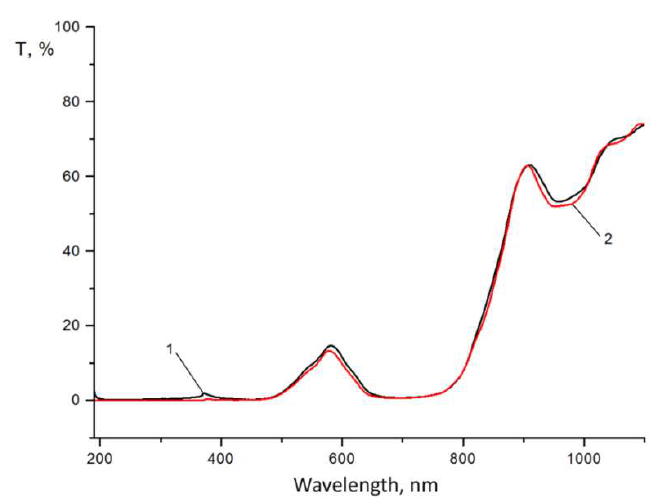
Figure 5. Optical transmittance in the ultraviolet and visible regions of the spectrum of rounded samples 1 and 2 with interference Si–SiO coating, formed on a sapphire substrate with a diameter of 30 mm.